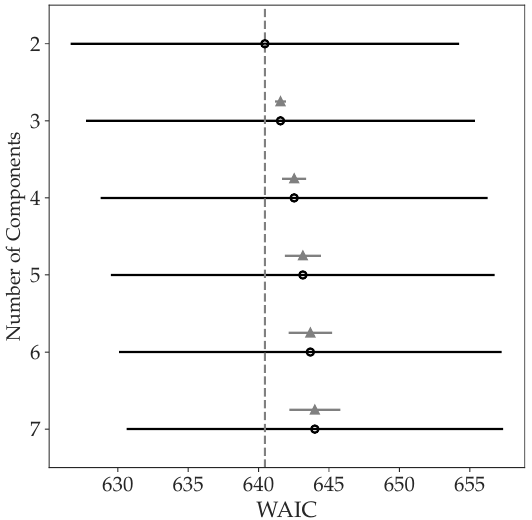
Figure 22. WAIC values with different K ’s. The open points stand for the WAIC values. The long horizontal line presents the standard error for each WAIC. Standard error of the difference in the WAIC’s between each model and the top-ranked one is illustrated using the short line with a triangle on